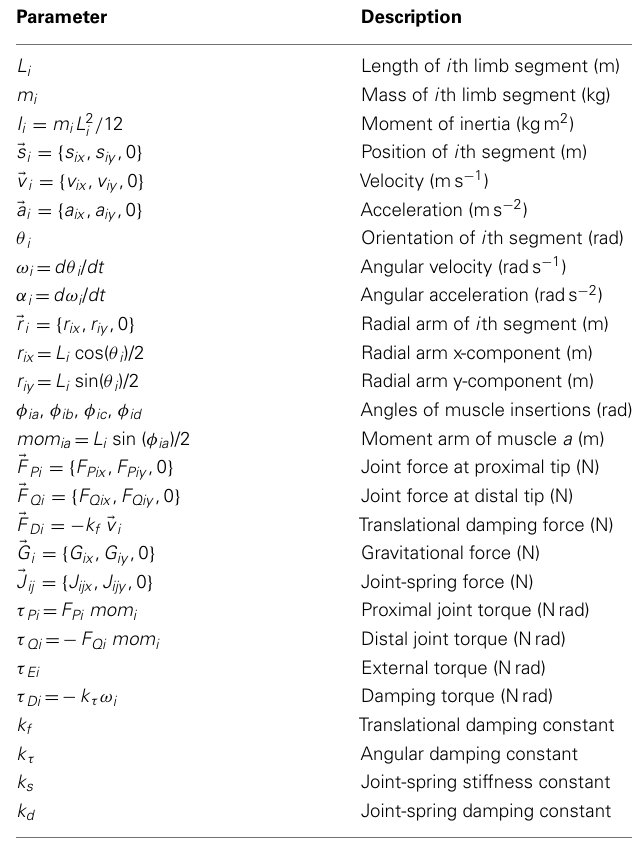
Table 1 | Description of all parameters related to the forward